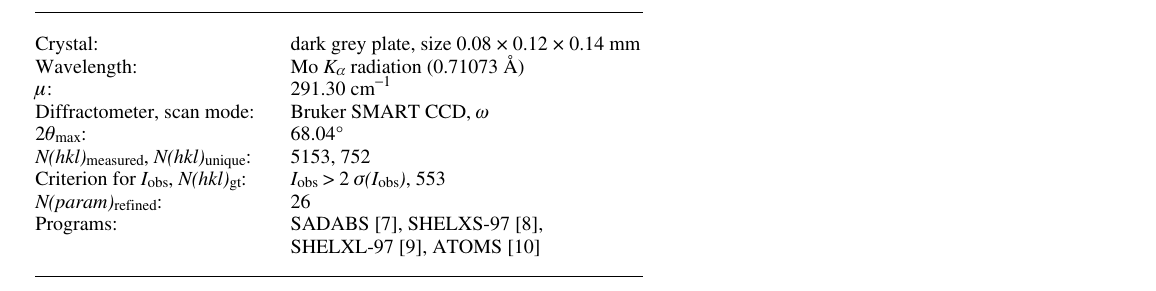
Table 3. Data collection and handling.